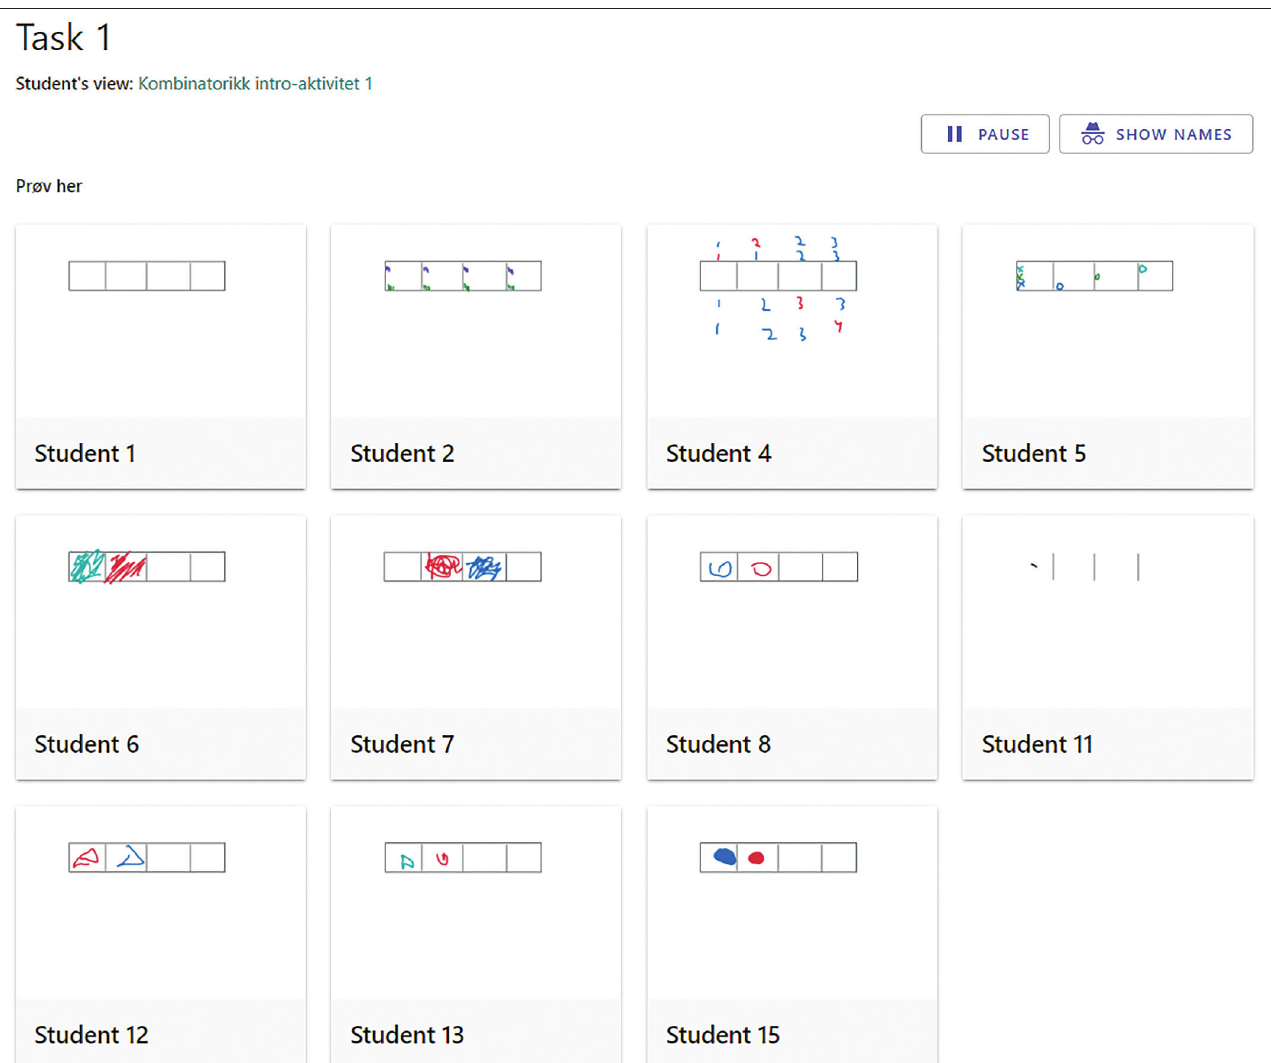
FIGURE 2-A1: Screenshot of the works of Students after two and four minutes using the Class function in